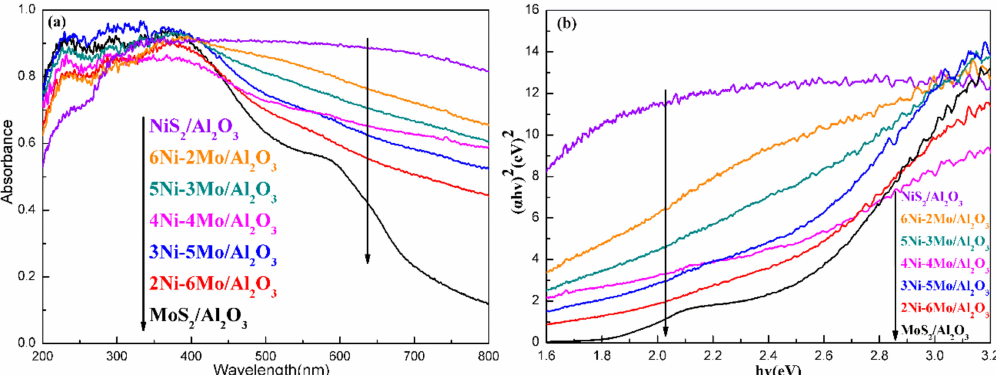
Figure 2. UV-vis di ff use reflection spectra for the Ni-Mo sulfide / Al 2 O 3 catalysts with di ff erent Ni / Mo molar ratios ( a ) relationship of absorbance and wavelength; ( b ) relationship of absorption coe ffi cient and incident photon